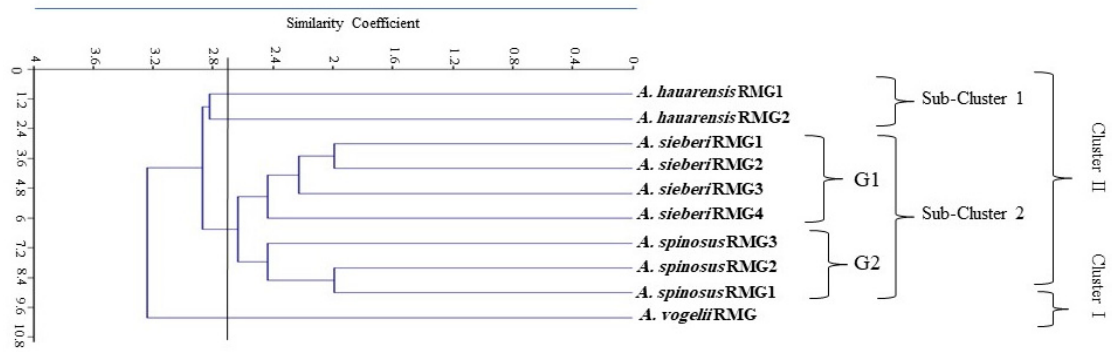
Figure 6. UPGMA dendrogram matrix illustrating the relationship between Astragalus specimens based on SCoT marker. ITS2 gene sequence was used to identify plants by using BLAST searched on NCBI database. Afterwards, analyzing the chromatogram for ITS region, 10 samples have been identified as two samples representing A. hauarensis , four samples representing A. sieberi , three samples representing A. spinosus, and one sample representing A. vogelii .